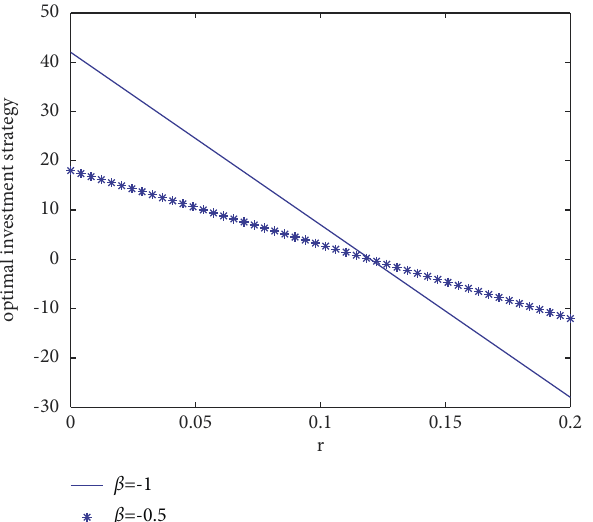
Figure 3: Influence of S on optimal investment ratio π ∗ t